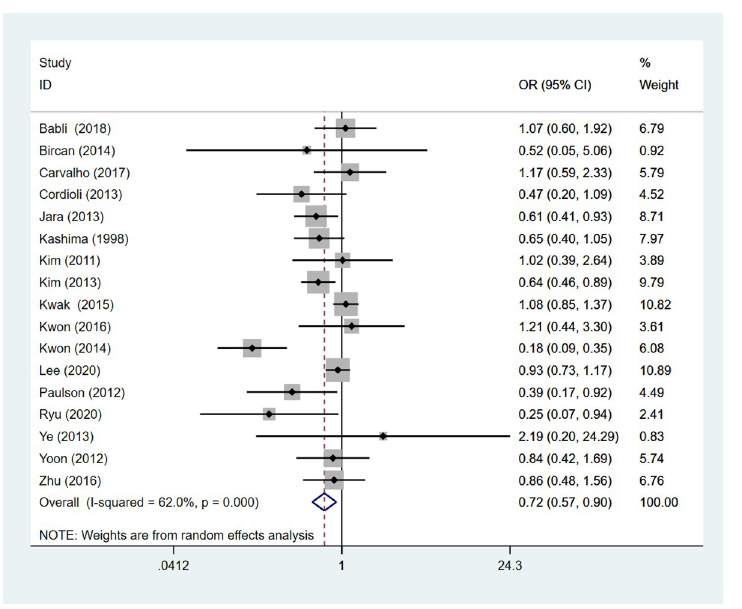
Fig 6. The forest plot of vascular invasion between HT group and non-HT group.